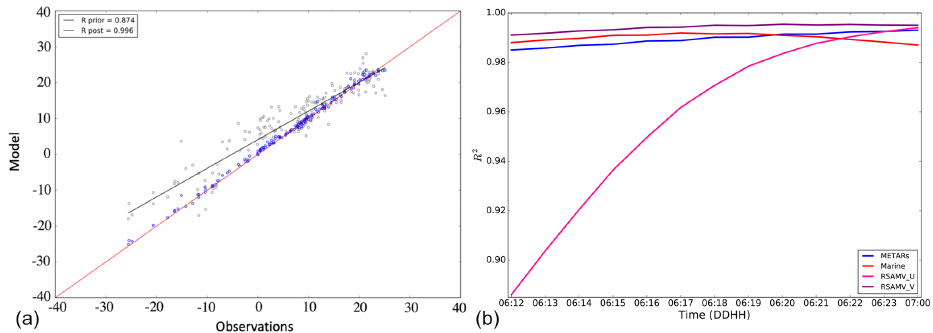
Figure 9. (a) Squared correlation coefficient computed before (grey dots) and after (blue dots) the assimilation of pressure data from maritime buoys, referred to as prior and posterior, at 00:00UTC, 7 November. The black line represents the prior linear regression line, and the red line represents a perfect linear regression line. (b) Evolution of the squared correlation for different observation types assimilated during the entire assimilation window is